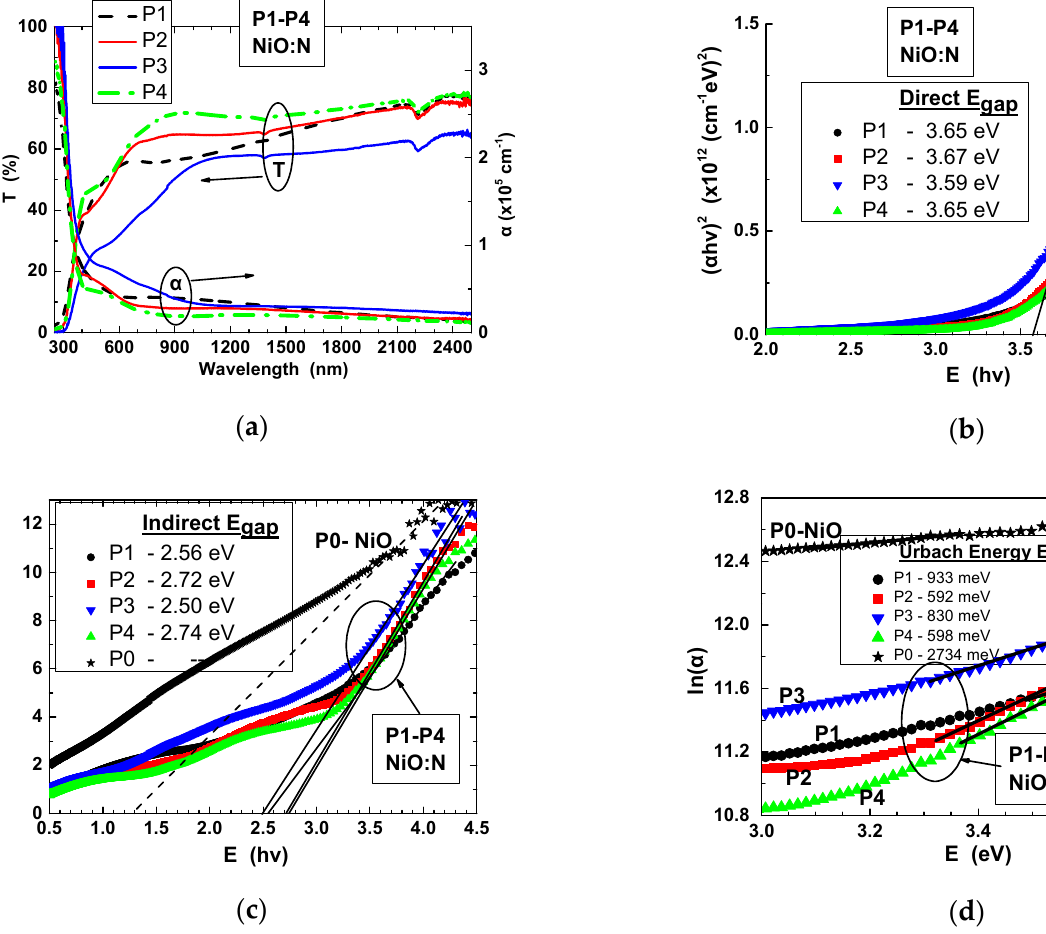
Figure 4. Optical properties of N-doped NiO films P1-P4 fabricated under different plasma conditions: ( a ) UV-Vis-NIR transmittance and absorption coefficient curves, ( b – d ) direct band gap, indirect band gap and Urbach tail states energy width determinations,